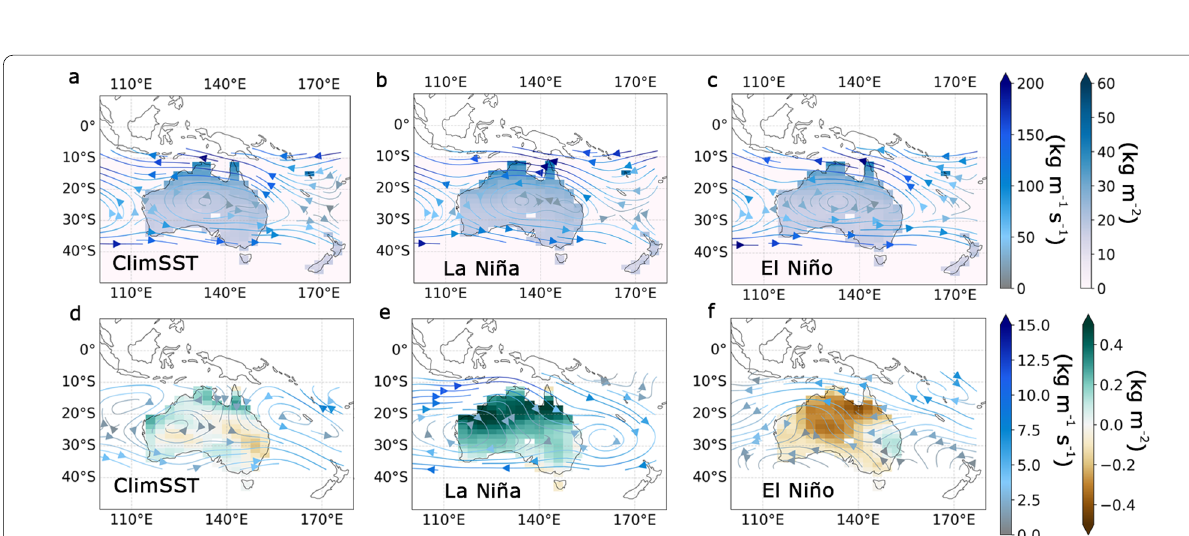
Fig. 7 Moisture transport (primary axis) and precipitable water (secondary axis) before (top row) and after the greening (bottom row). The top row shows the patterns of moisture transport (contour) and precipitable water (shading) prior to greening for the three simulation SST forcings: a climatological mean SST; b La Niña SST; and c El Niño SST. The magnitude of moisture transport is calculated as u and v components of moisture v 2 ). The bottom row of figures shows the changes in moisture transport and precipitable water under greening for the same three flux ( √ u 2 + simulation SST forcings: d climatological mean SST; e La Niña SST; and f El Niño SST. The arrows indicate the changes in moisture transport, for which the magnitude is calculated as the changes of u and v components of moisture flux ( (cid:31) (cid:31) u 2